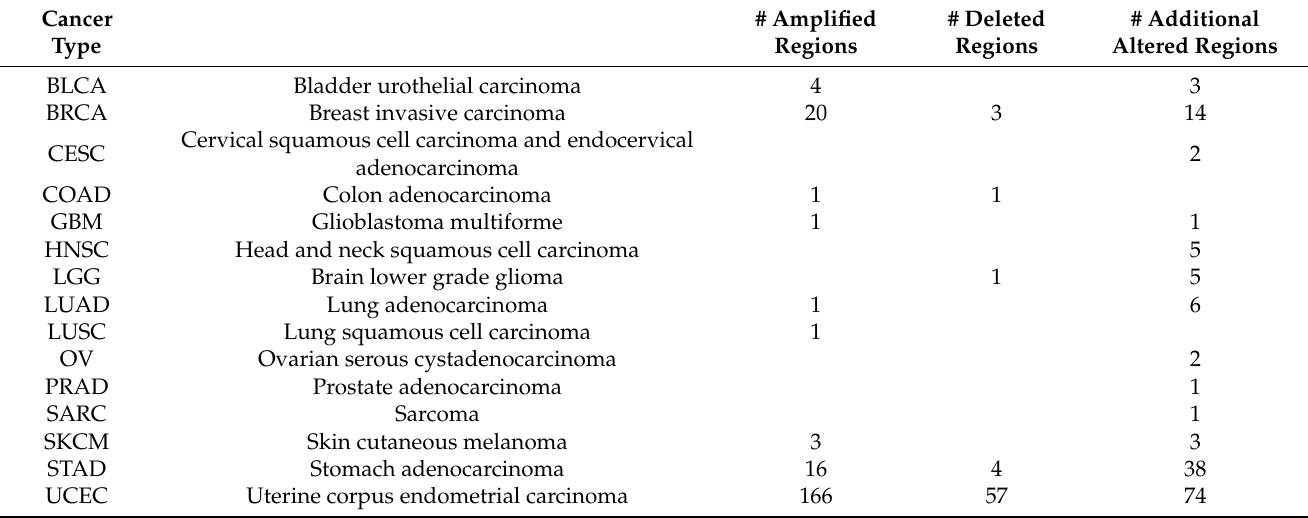
Table 1. Number of significant CNA regions per cancer